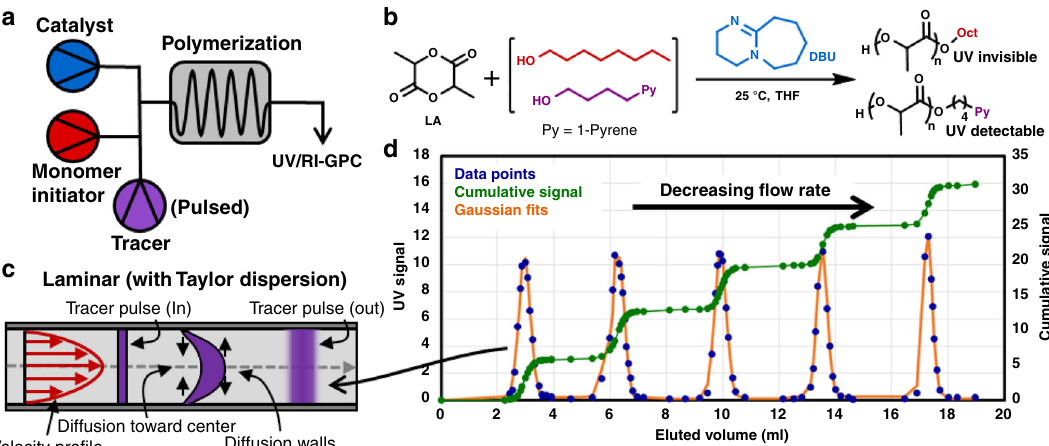
Fig. 3 Reactor design, chemistry, fl uid fl ow diagram, and data for polymer tracer experiments. a Flow reactor con fi guration for the tracer experiments. b DBU catalyzed ROP of lactide with an octanol initiator. A UV detectable (266 nm) pyrene initiator will periodically be pulsed into the fl ow reactor as the tracer. c Depiction of laminar fl ow with Taylor dispersion. d Experimental data of tracer pulses for different fl ow rates in a single run.